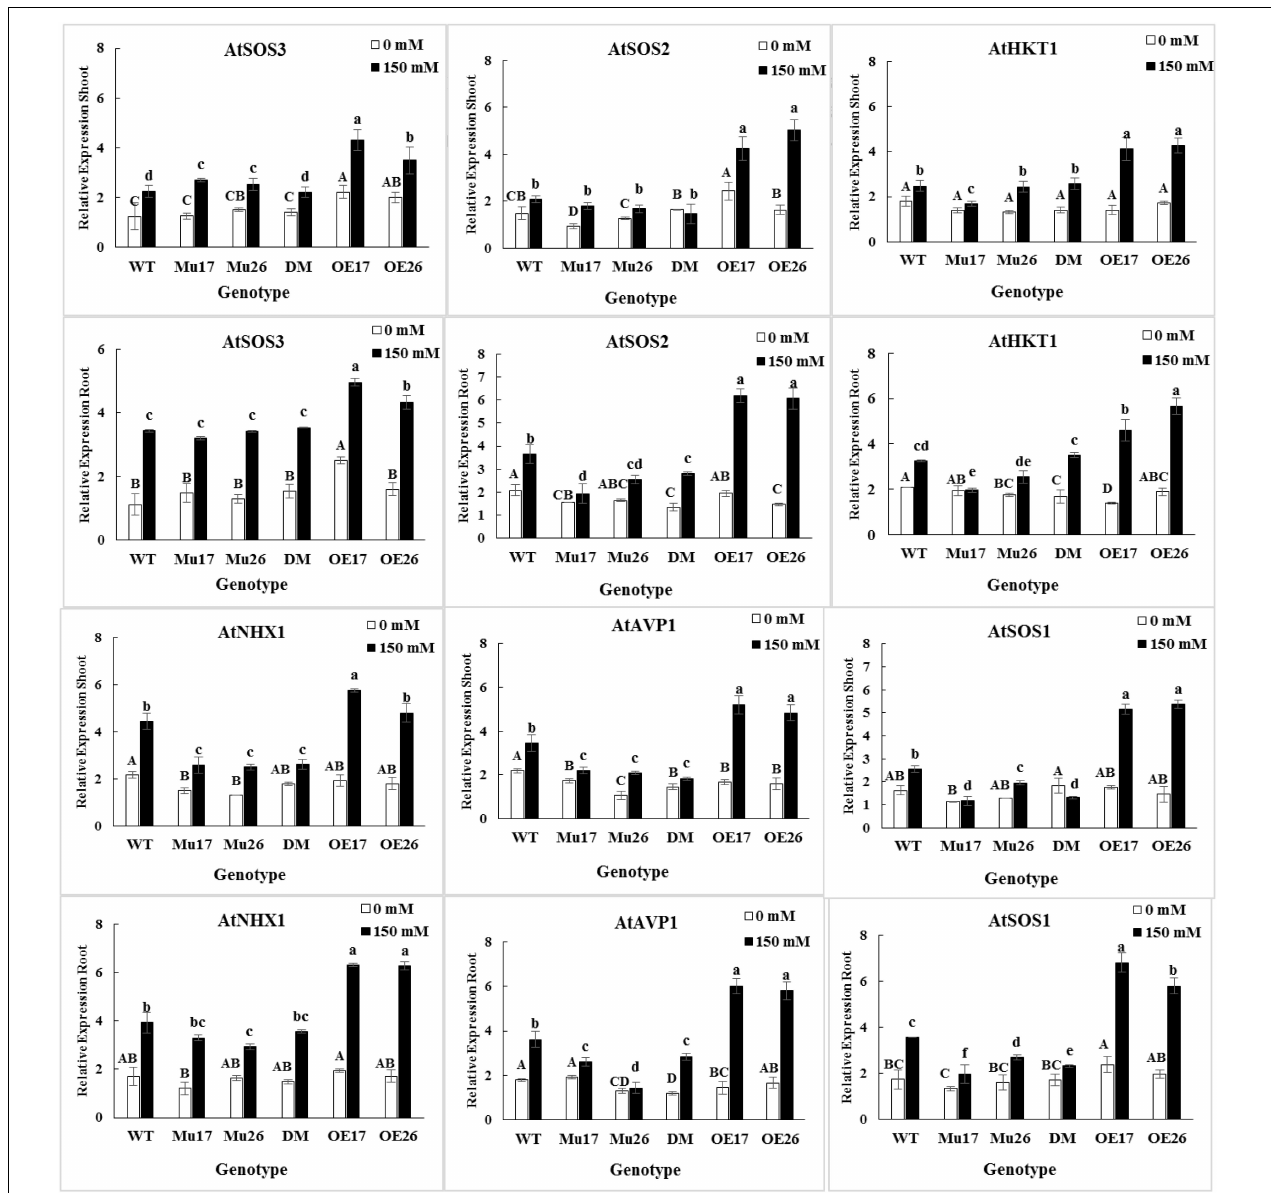
FIGURE 4 | The expression level of mentioned genes in shoots and roots of genotypes subjected to 150 mM NaCl stress compared to no NaCl stress. Wild-type (WT), overexpress (OE), single mutant (Mu), and double mutant (DM) genotypes of Arabidopsis thaliana purple acid phosphatase 17 ( AtPAP17 ) and 26 ( AtPAP26 ) genes. The significant mean differences ( P < 0.05) were separately shown at 0 and 150 mM NaCl concentrations with different uppercase and lowercase letters,